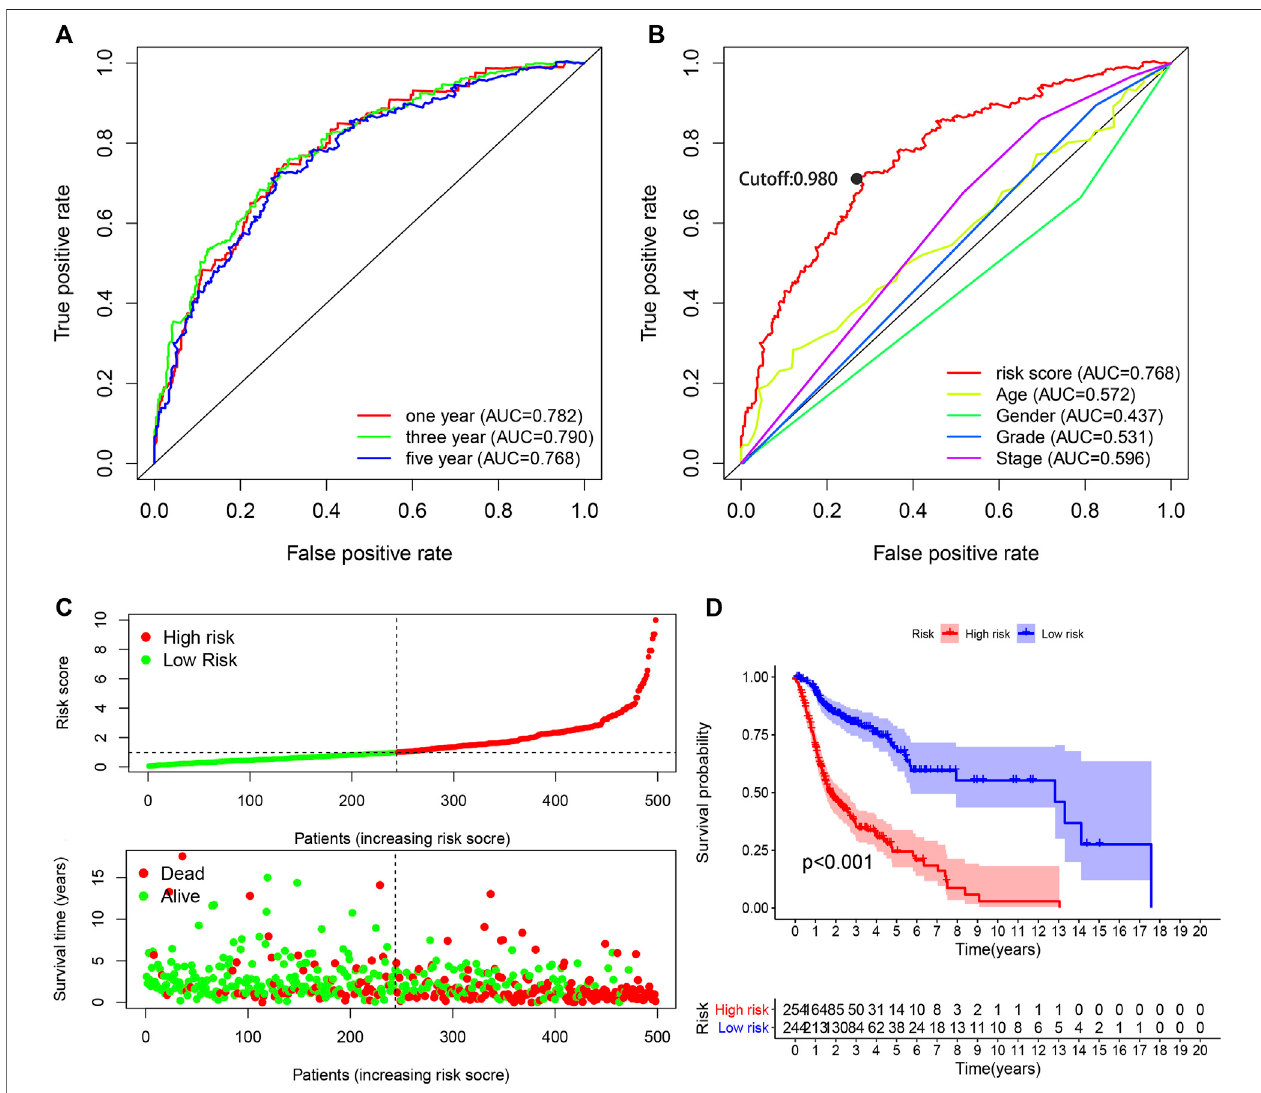
FIGURE3| Performanceevaluationoftheriskmodelforsurvivalprediction. (A) One-,three-,and fi ve-yearROCcurvesoftheoptimal modelindicating thatallAUC values were more than 0.75. (B) A comparison of 5-year ROC curves with other clinical characteristics illustrating the superiority of this model. The maximum in fl ection point was the cut-off point obtained by the AIC. (C) Risk scores and survival outcome of each case. (D) The survival time of the high-risk group was shorter based on Kaplan – Meier analysis.